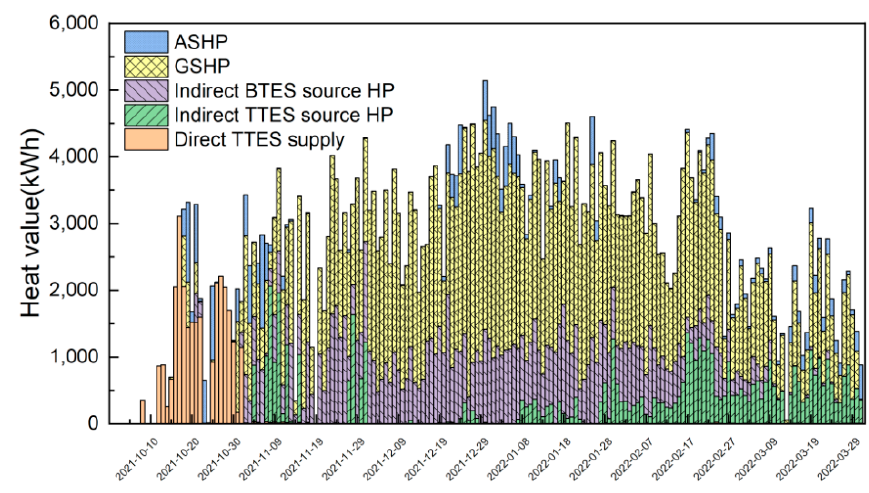
Figure 5. Daily heat balance of the TTES.